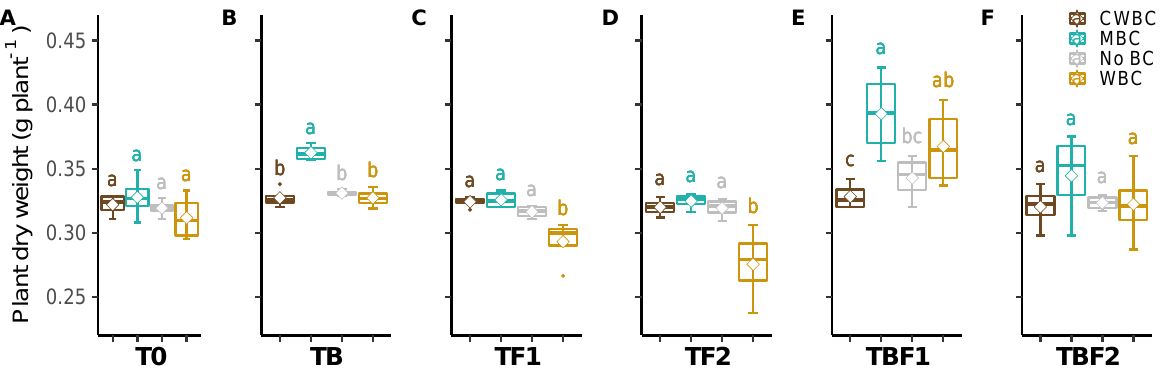
Figure 1. Effect of microbial inoculants on plant dry weight after biochar application. Un-inoculated control (T0, A ), inoculated with Klebsiella sp. BS13 (TB, B ), inoculated with Talaromyces purpureogenus BS16aPP (TF1, C ), inoculated with Talaromyces calidicanius RS10bPP (TF2, D ), inoculated with Klebsiella sp. BS13 + Talaromyces calidicanius RS10bPP (TBF1, E ), and inoculated with Klebsiella sp. BS13 + Talaromyces purpureogenus BS16aPP (TBF2, F ). Quantiles are shown at the top and bottom of the box. Max and min values are indicated by the bars. The lines within the box indicate the median values. The transparent dot indicates the observation value. Letters above the bars indicate the significance level at p < 0.05 by LSD. CWBC — black cherry wood biochar, MBC — pyrolysis biochar from maize, No BC — without biochar, WBC — pyrolysis biochar from wood.